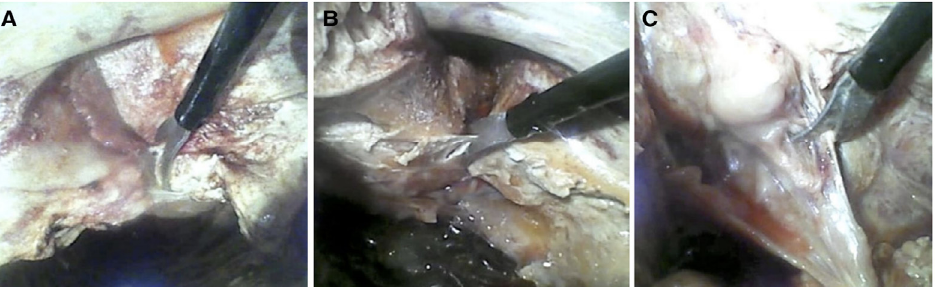
Figure 1. Mesorectal excision restricted by rigid straight-light laparoscopic tool. Lateral completion on the right side ( A ), the left side ( B ) and the anterior side ( C ) [3].